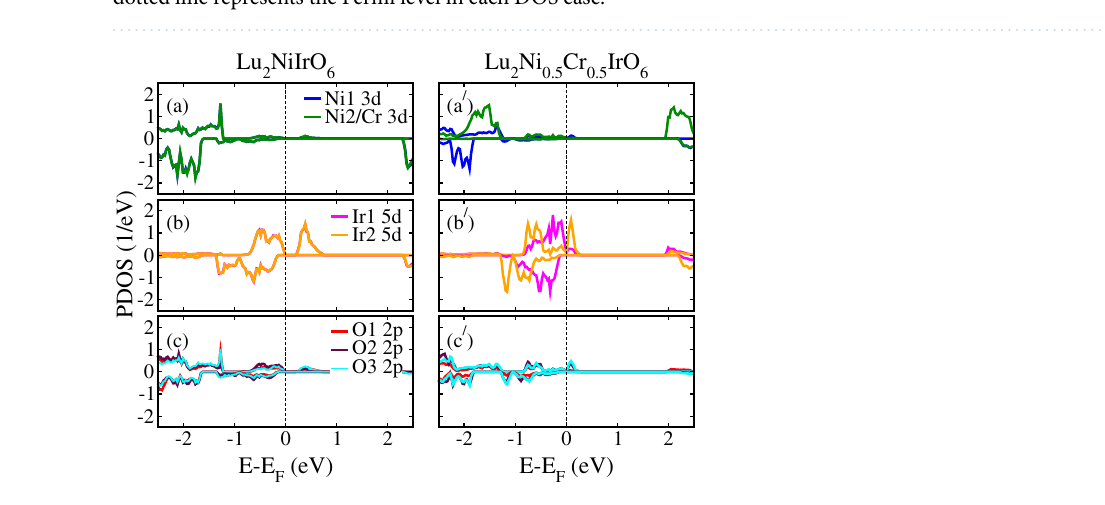
Figure 4. Calculated spin-polarized total density of states (TDOS) within a GGA + U method for ( a ) undoped Lu 2 NiIrO 6 , ( b ) Cr-doped Lu 2 NiIrO 6 ( Lu 2 Ni 0.5 Cr 0.5 IrO 6 ), ( c ) Mn-doped Lu 2 NiIrO 6 ( Lu 2 Ni 0.5 Mn 0.5 IrO 6 ), and ( d ) Fe-doped Lu 2 NiIrO 6 ( Lu 2 Ni 0.5 Fe 0.5 IrO 6 ) double perovskite oxides in a FiM-I spin ordering. The verticle dotted line represents the Fermi level in each DOS case.